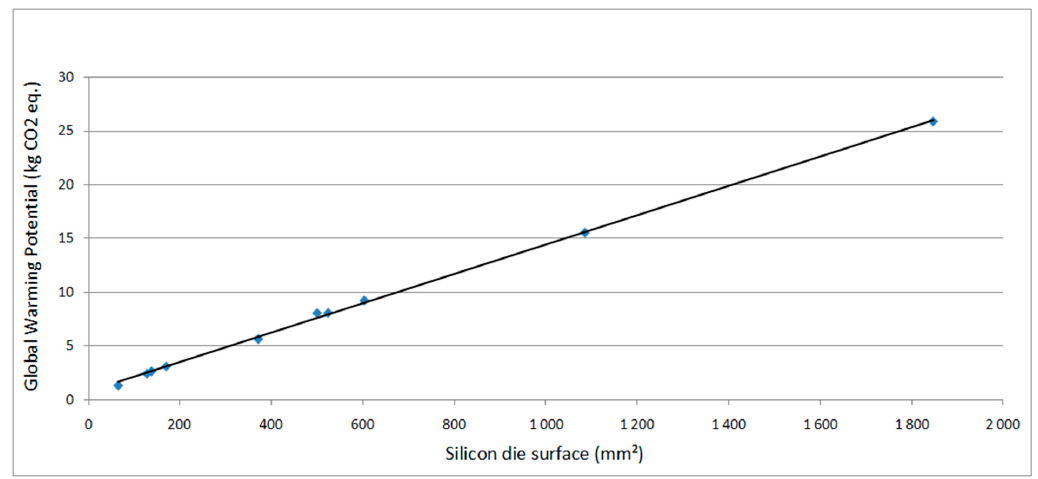
Figure 1. Silicon die surface ( Si area ) used for the Global Warming Potential Indicator (GWPI) in OLCA.